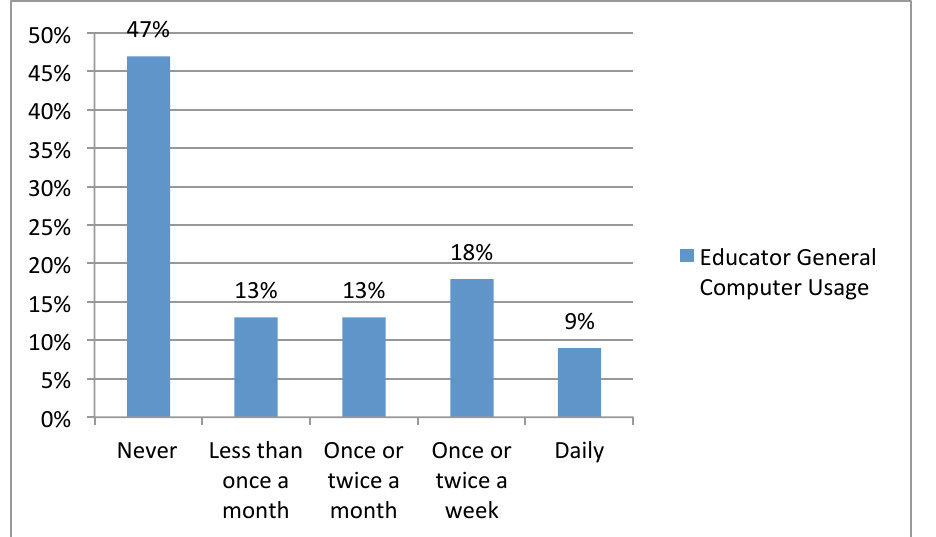
Figure 1: Educators’ general computer